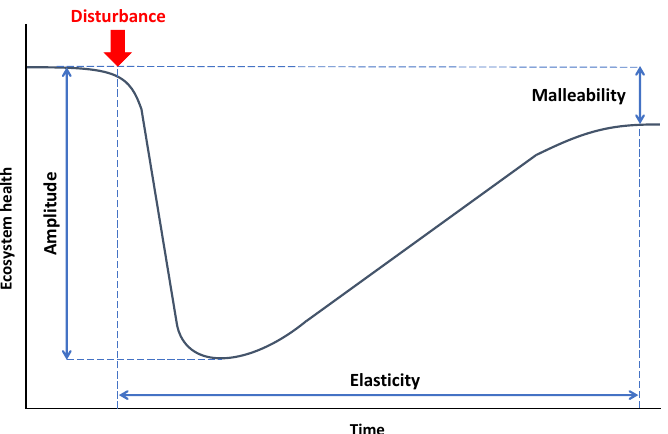
Figure 1. Resilience concepts of an